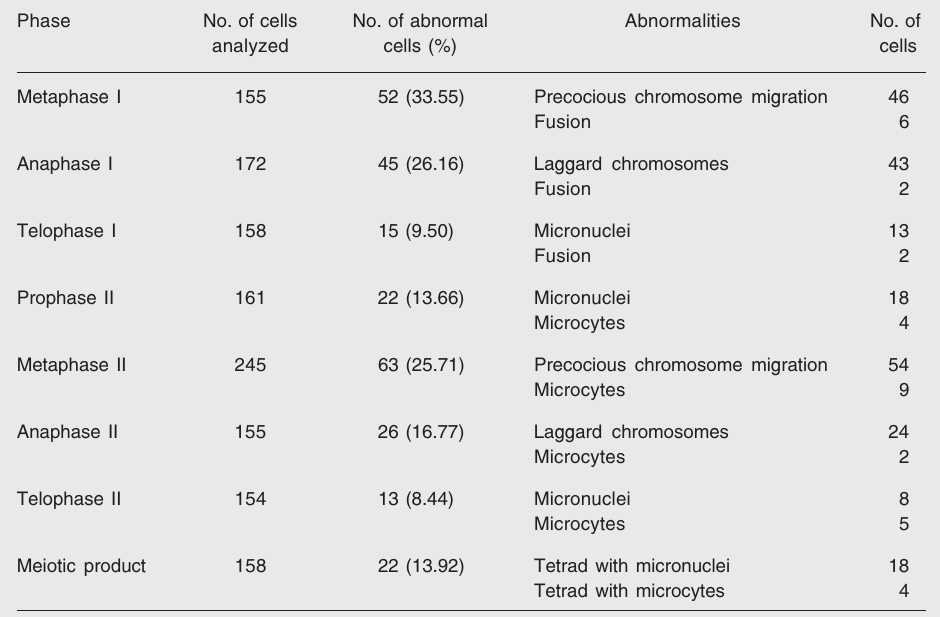
Table 1. Frequency of abnormalities recorded in Brachiaria jubata pollen during microsporogenesis. Phase No. of cells No. of